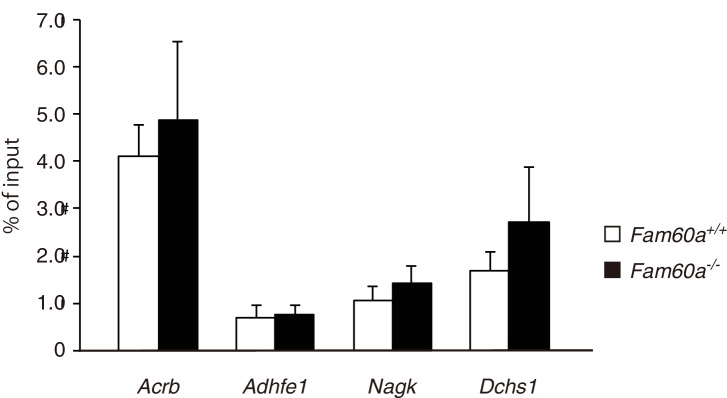
ChIP-qPCR analysis of AcH3K9 at Fam60a target gene promoters.E9.5 WT and Fam60a–/– embryos were subjected to ChIP-qPCR analysis with antibodies to AcH3K9. Data are expressed as percentage of input and are means ± s.d. for four independent experiments. Values for control IgG were essentially 0% and are therefore not shown.